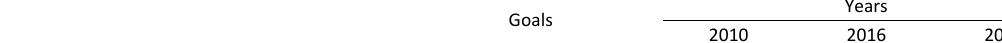
Table 6: Comprehensive assessment of the organizational and economic mechanism of the regulatory policy effectiveness in Ukrainian agriculture 2010-2016, 2017 ( State Statistics Service of Ukraine, 2017; Legislation of Ukraine,